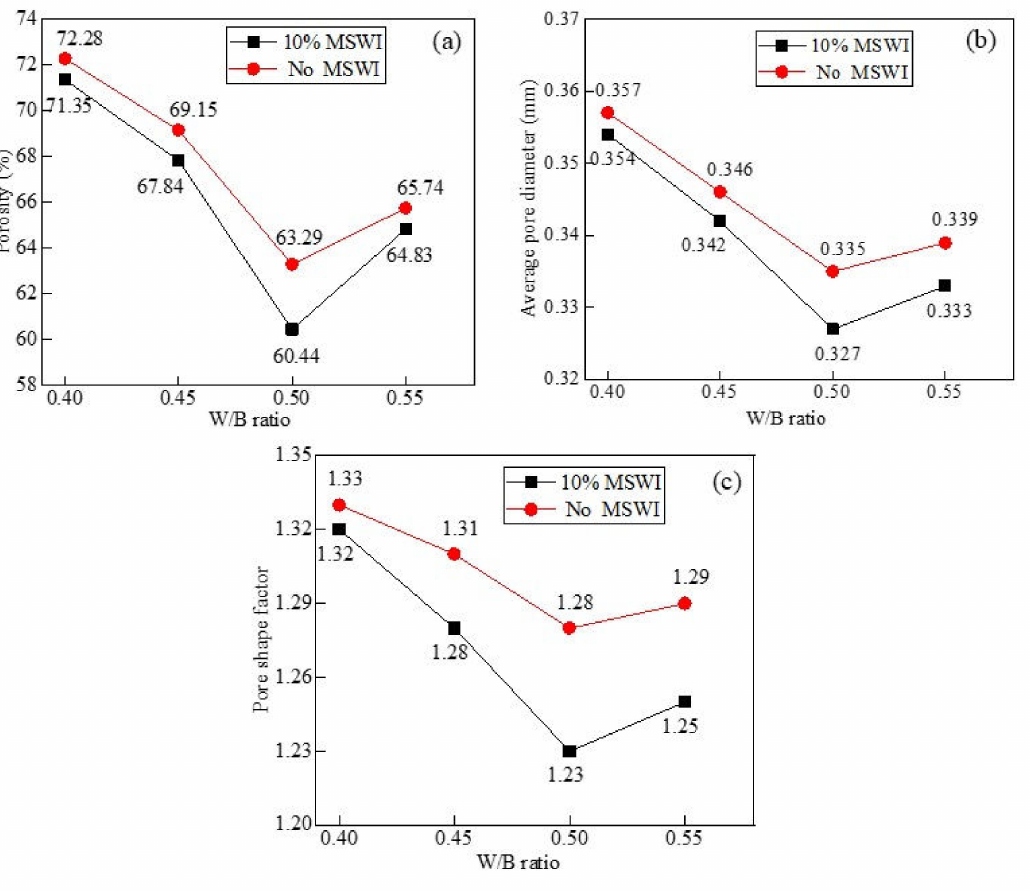
Figure 12. Porosity ( a ), average pore diameter ( b ), and pore shape factor ( c ) of the recycled foamed concrete containing MSWI powder with different water–binder